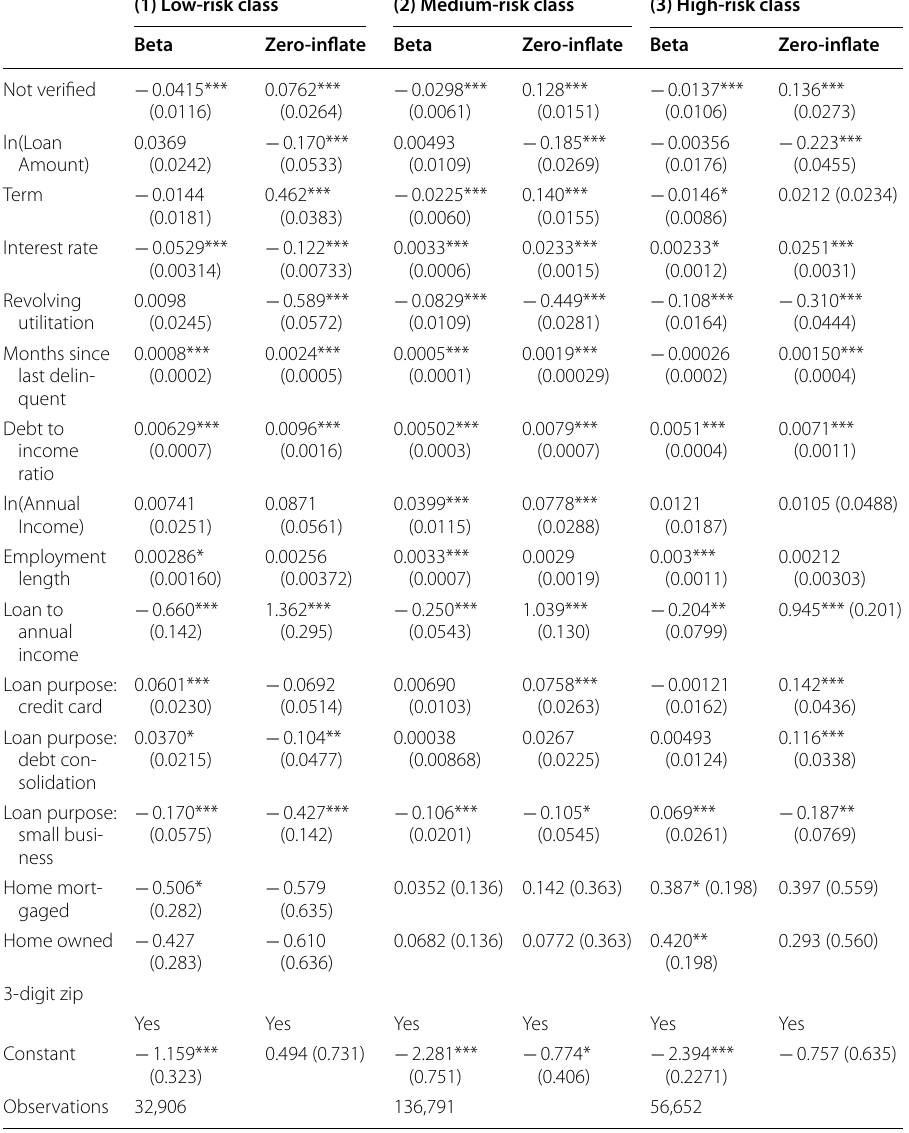
Table 10 Regression results within each